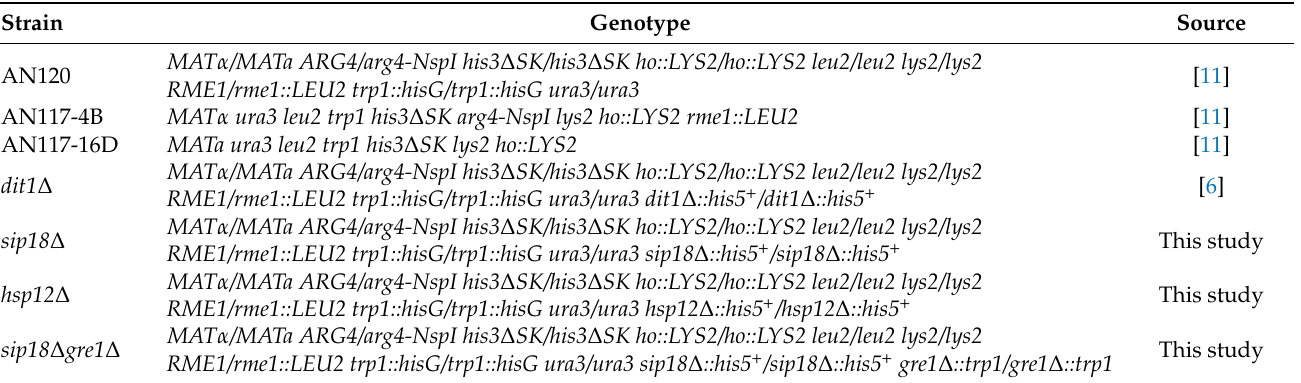
Table 1. Strains used in this